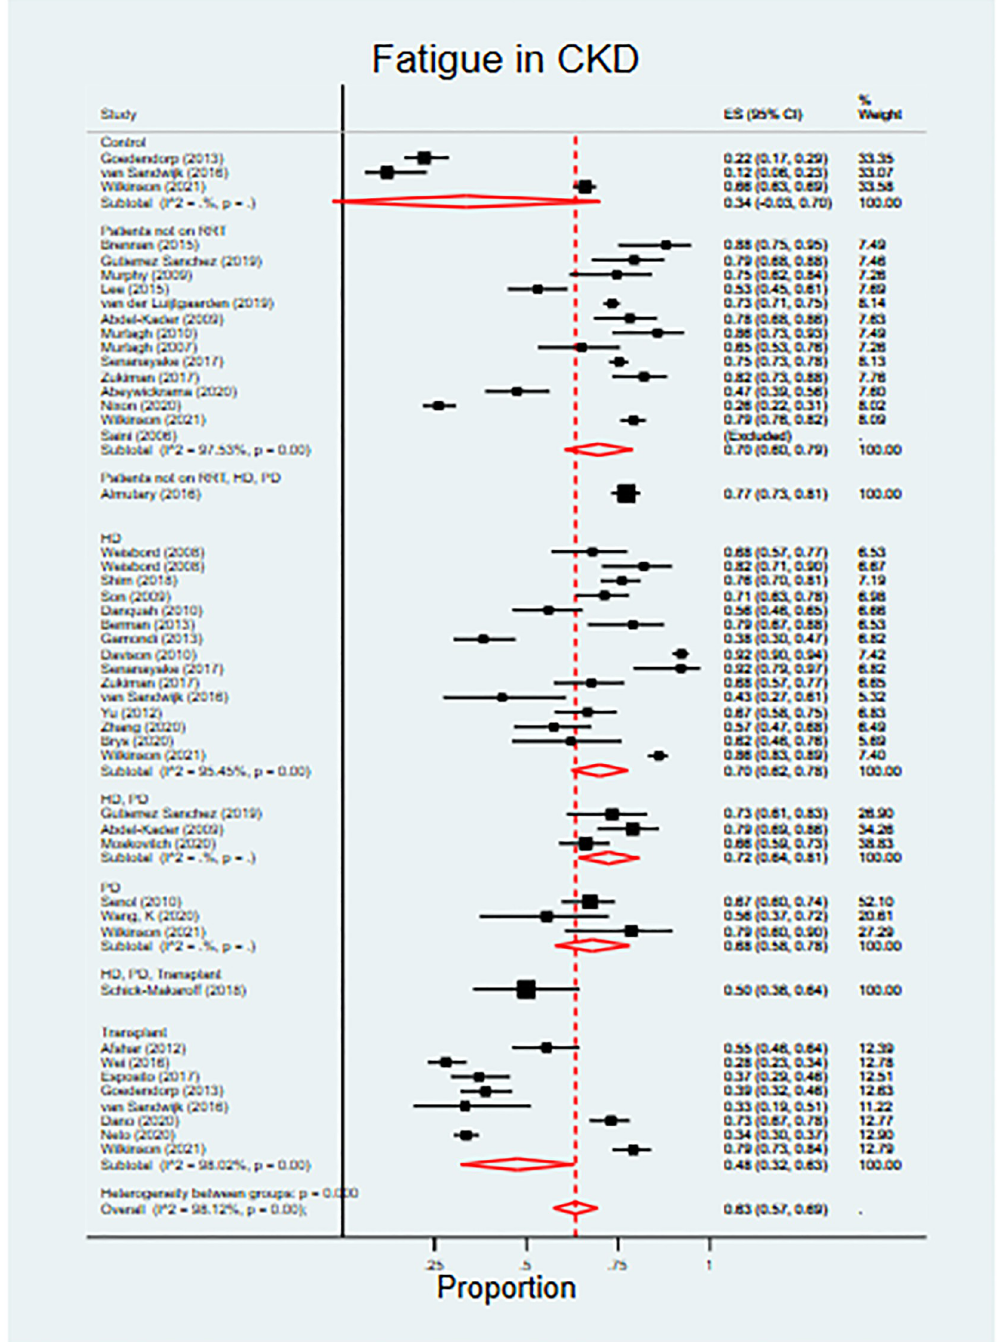
Fig 8 AU : IaddedthefollowingsentencetothelegendforFig 8 : SeeS 4 Appendixforfullreferencesforincludedstudies : Ifthisisnotcorrect ; pleaseeditasnecessary : PerPLOScopyeditingguidelines ; IdonotcopyeditSupportingInformationfiles ; butIcross (cid:0) checkedthefirstfewstudiesinFig 8 againstS 4 Appendix ; andthepublicationyeargivenforthevanSandwijkstudyinFig 8 andS 4 Appendixdoesnotmatch ð 2016 versus 2019 Þ : IrecommendcheckingthatallstudyinformationiscorrectandmatchinginFig 8 andS 4 Appendix ; andmakinganynecessarycorrections : . Prevalence of fatigue in chronic kidney disease. See S4 Appendix for full references for included studies. ES, effect size; HD, haemodialysis; PD, peritoneal dialysis; RRT, renal replacement therapy.